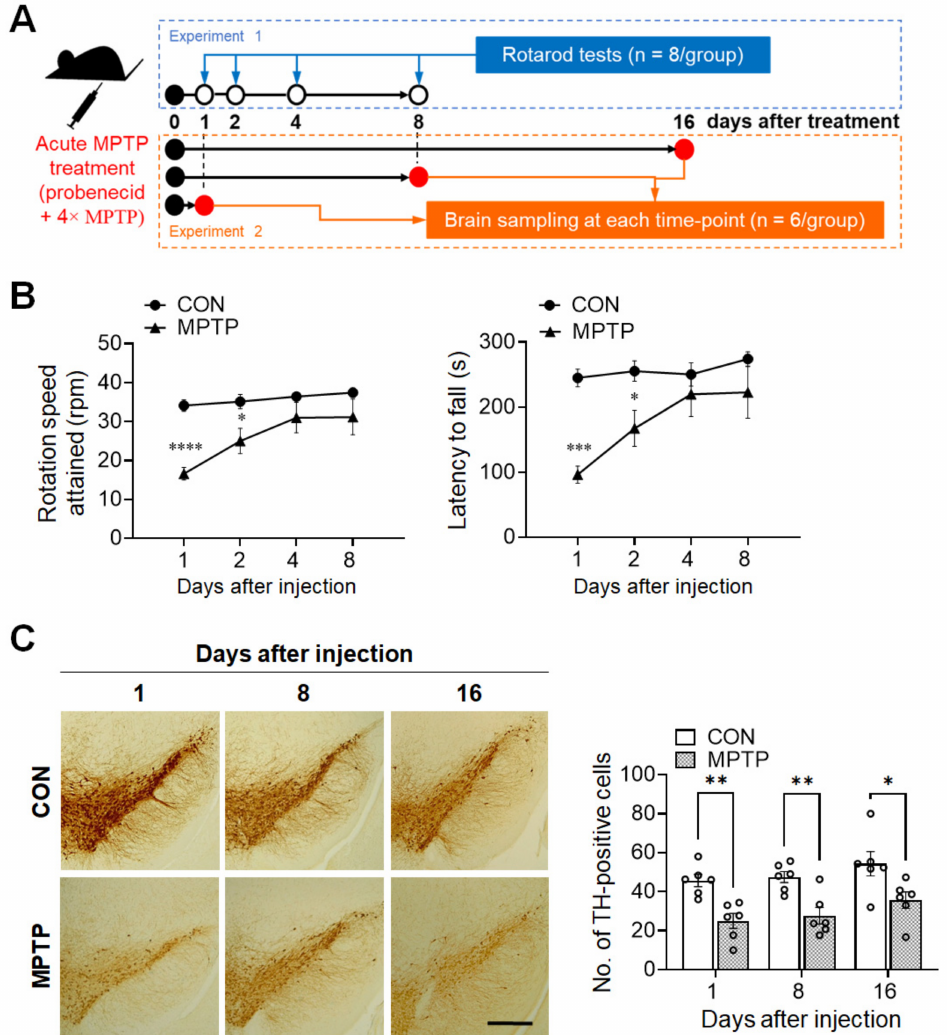
Figure 1. Acute MPTP (1-methyl-4-phenyl-1,2,3,6-tetrahydropyridine) treatment triggered initial motor impairment and persistently decreased tyrosine hydroxylase (TH) immunoreactivity in the substantia nigra. ( A ) Schematic representation of the experimental design. In experiment 1, the rotarod test was performed at 1, 2, 4, and 8 days after acute MPTP injection (4 × 22 mg/kg, 2 h inter- vals). In experiment 2, mice were sacrificed at 1, 8, and 16 days post-injection, and brain samples were collected for immunohistochemical analysis and Golgi staining. ( B ) Motor function was evaluated using the rotarod test. Early phase (at 1 and 2 days) after MPTP treatment, mice showed a significant decrease in the rotation speed attained and latency to fall in the early phase. ( C ) TH immunoreactivity in the substantia nigra was significantly lower at 1, 8, and 16 days after injection in the MPTP group than in the control (CON) group. Data are expressed as mean ± standard error ( n = 8 mice/group for rotarod; n = 6 hemispheres/group at each time point for the TH immunoreaction). The scale bar ( C ) represents 200 µ m. * p <0.05, ** p < 0.01, *** p < 0.001, **** p < 0.0001 between the CON